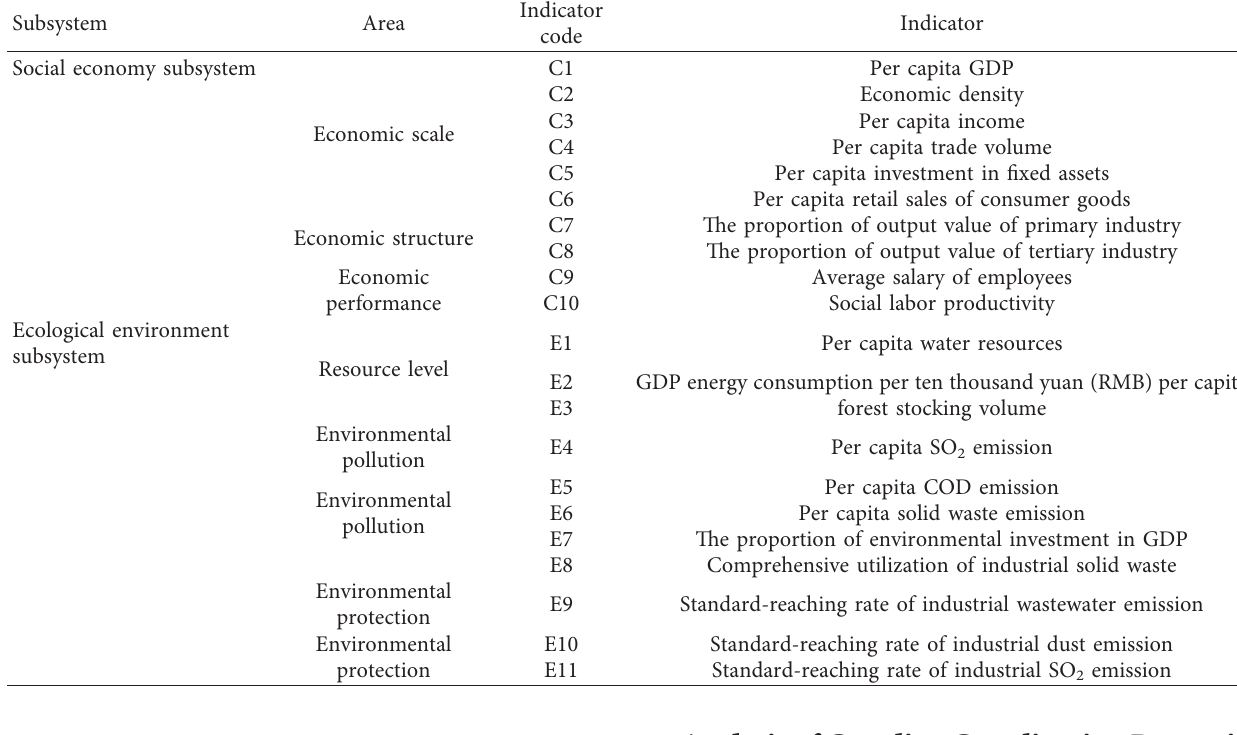
Table 1: Evaluating indicator system of SE and EE